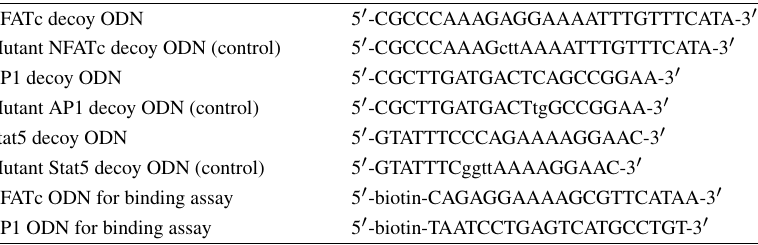
The sequence of ODN (double stranded phosphorothioate